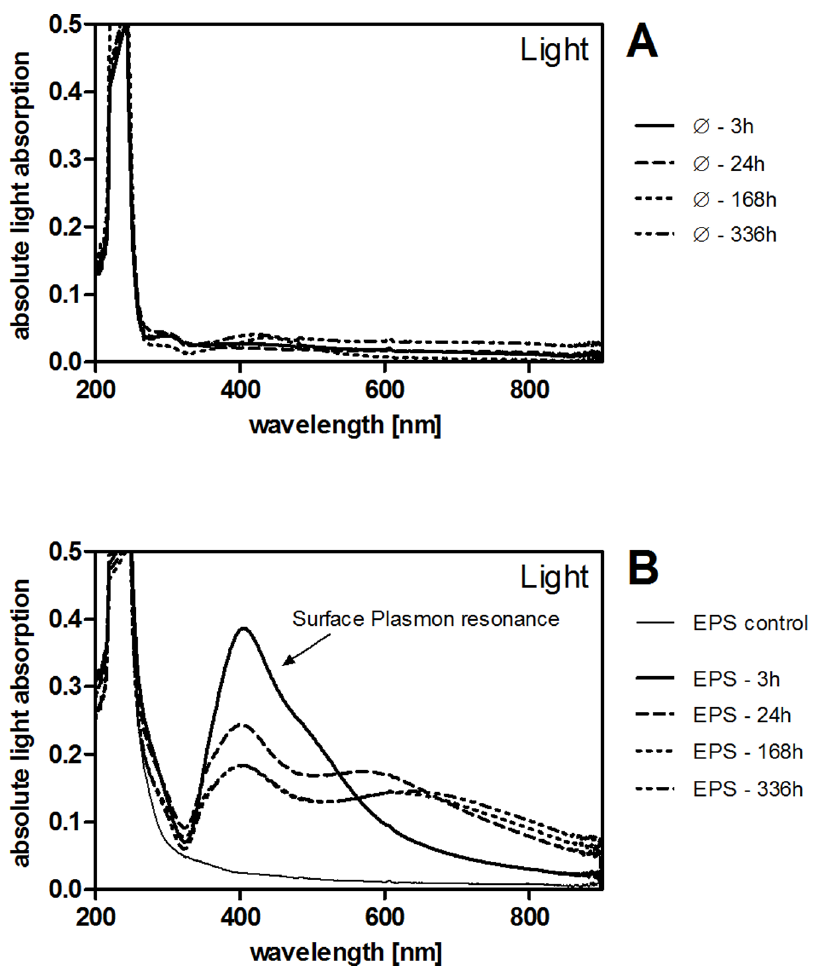
Figure 7. A–B: Spectra of light absorption of AgNO 3 solutions (5 mg/L Ag) as determined by UV-VIS spectroscopy. Samples were incubated in light (100 m E/m 2 s) at pH 6 without ( A ) or with EPS ( B , 10 mg DOC/L; 3 h –168 h spectra obtained with EPS extract 1; 336 h spectrum obtained with